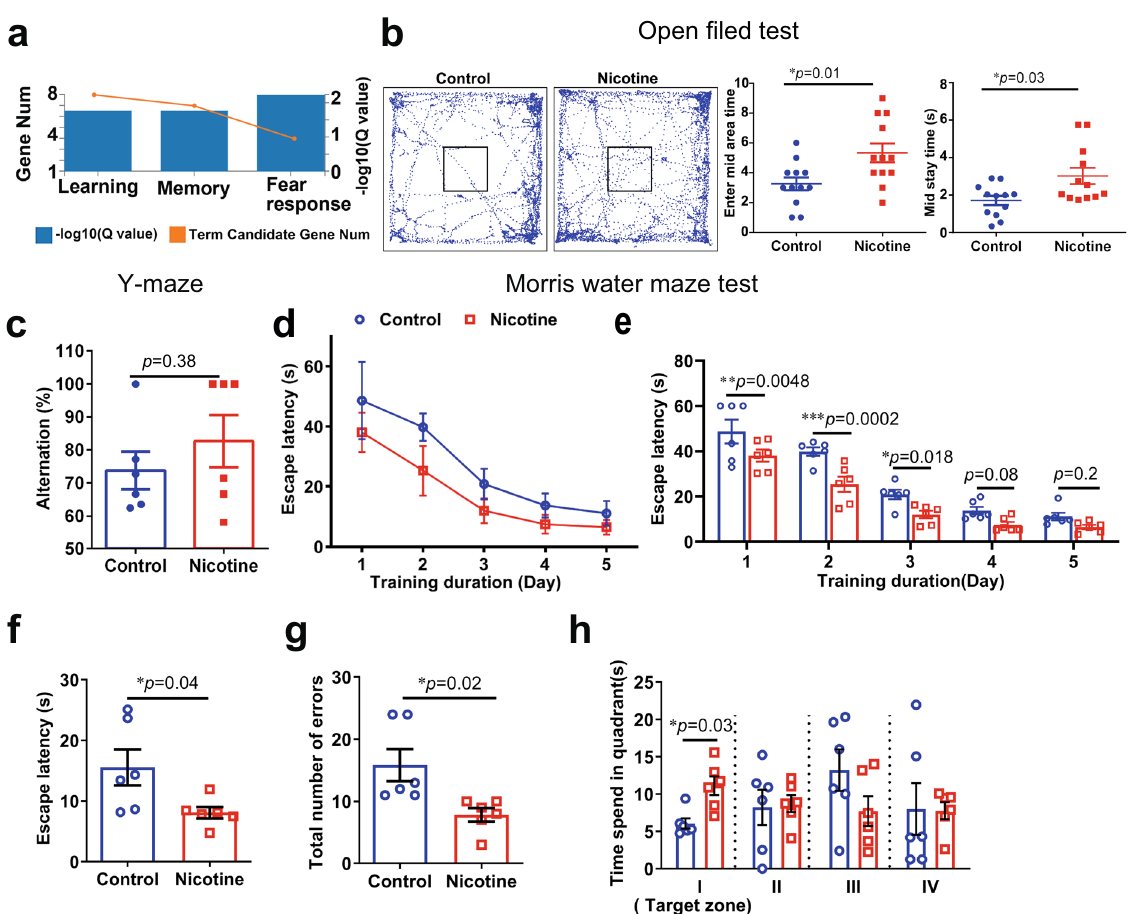
Fig. 9 | Nicotine ameliorated cognitive function of the aged mice. a The Gene KEGG pathways related to “ behavior ” : learning, memory and fear response. b Schematic of zones in the open fi eld arena and representative traces of with and without nicotine administration mice movement. Enter mid area times ( n =12, biologically independent samples/group) and mid stay time ( n =12, biologically independent samples/group) in open fi eld arena. c The alternation of aged mice with or without nicotine in the Y-maze test ( n =6, biologically independent